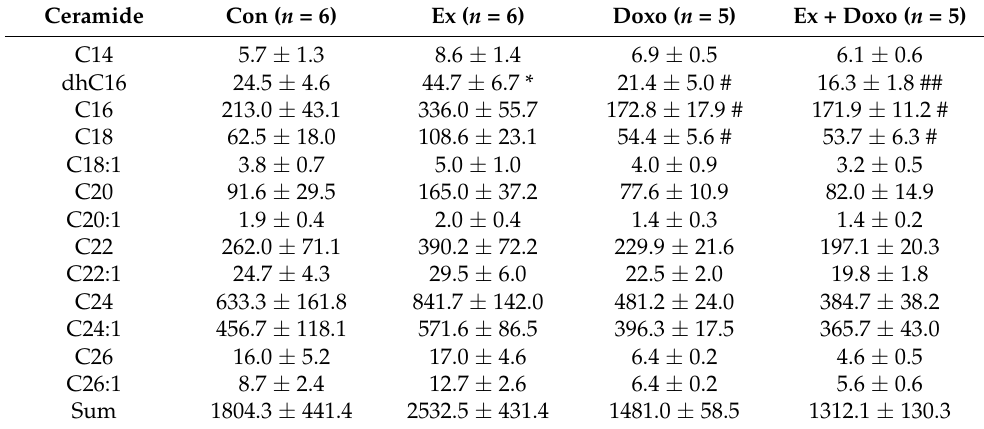
Table 1. Absolute concentration of ceramide species (pmol/mg) homogenates from B16F10 melanoma from Con, Ex, Doxo, and Ex + Doxo